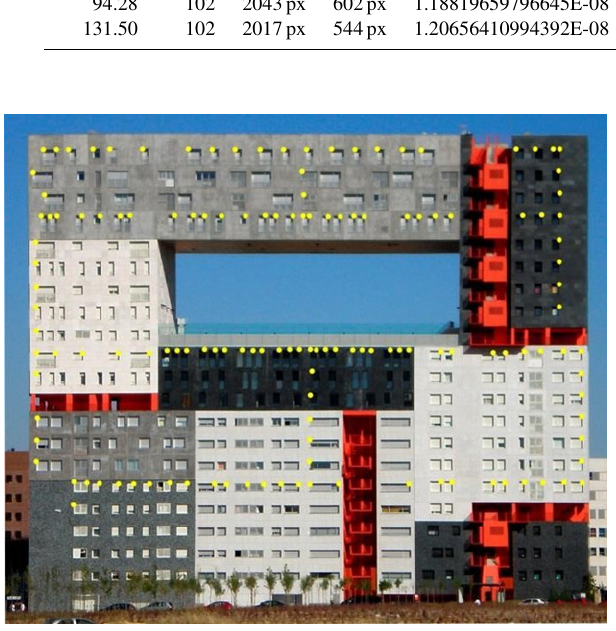
Figure 4. View of the facade of the building “Mirador”, where we did the calibration of the non-metric camera used for photographic shots of Johnsons Glacier front. In yellow, the points measured us- ing a total station.